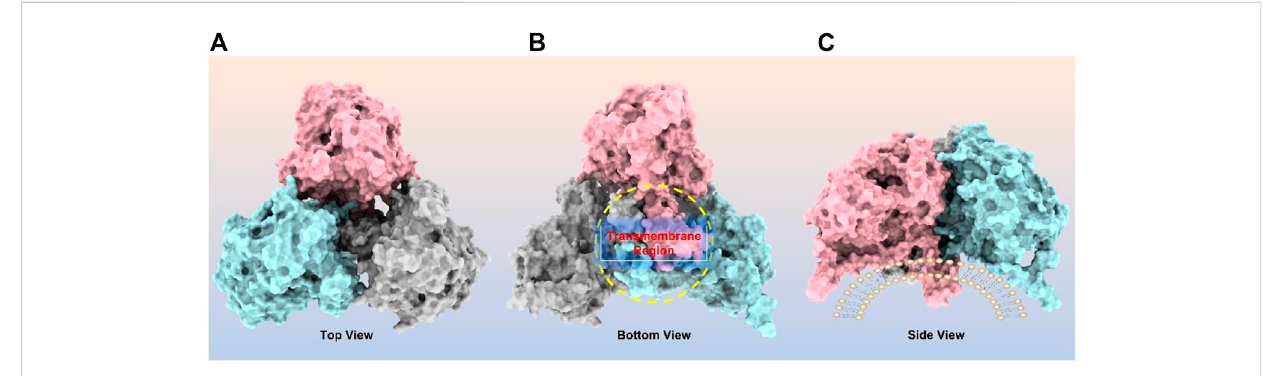
FIGURE 4 CPT1A homo-trimer structure predicted by ClusPro online server (https://cluspro.org/). (A) Top view of CPT1A trimer; (B) Bottom view of CPT1A trimer with transmembrane region highlighted by yellow circle; (C) Side view of CPT1A trimer located on mitochondrial outer